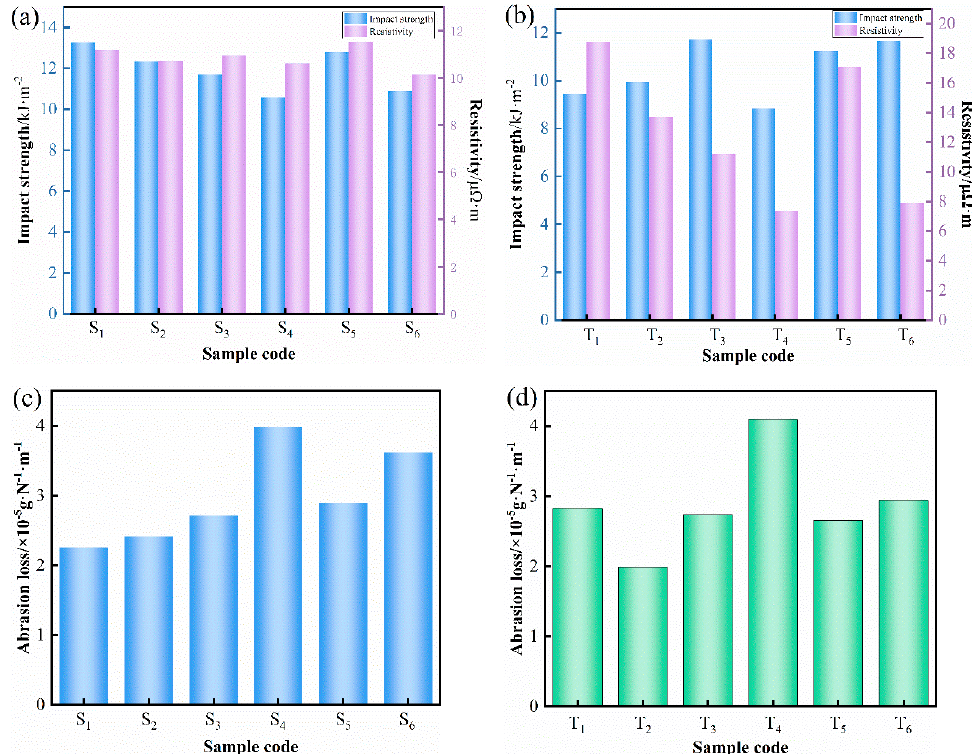
Figure 6. ( a ) Impact strength and resistivity and ( c ) abrasion loss of sliding plate of copper mesh with the same mass and different sizes. ( b ) Impact strength and resistivity and ( d ) abrasion loss of sliding plates with the same size but different copper meshes.